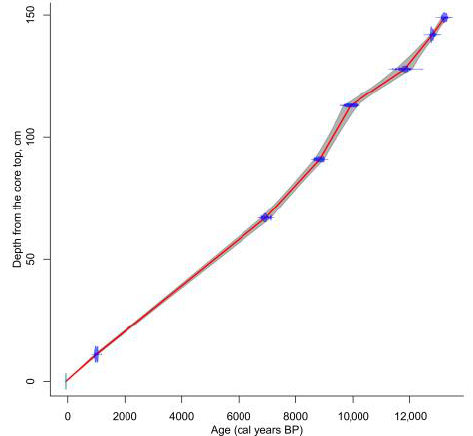
Figure 2. Results of applying the CLAM age-depth model of the Lake Kaskadnoe-1 core based on seven calibrated AMS radiocarbon dates (weighted mean age, dotted red line), overlaying the calibrated distributions of individual 14C ages (blue), with 95% probability intervals (gray shaded).